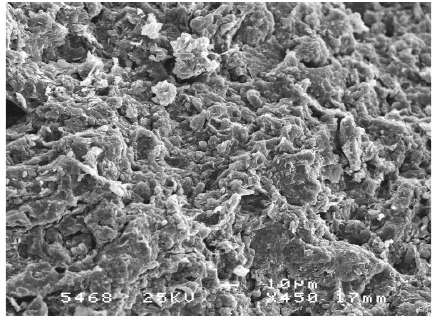
Figure 11: SEM image of untreated soil at × 450.